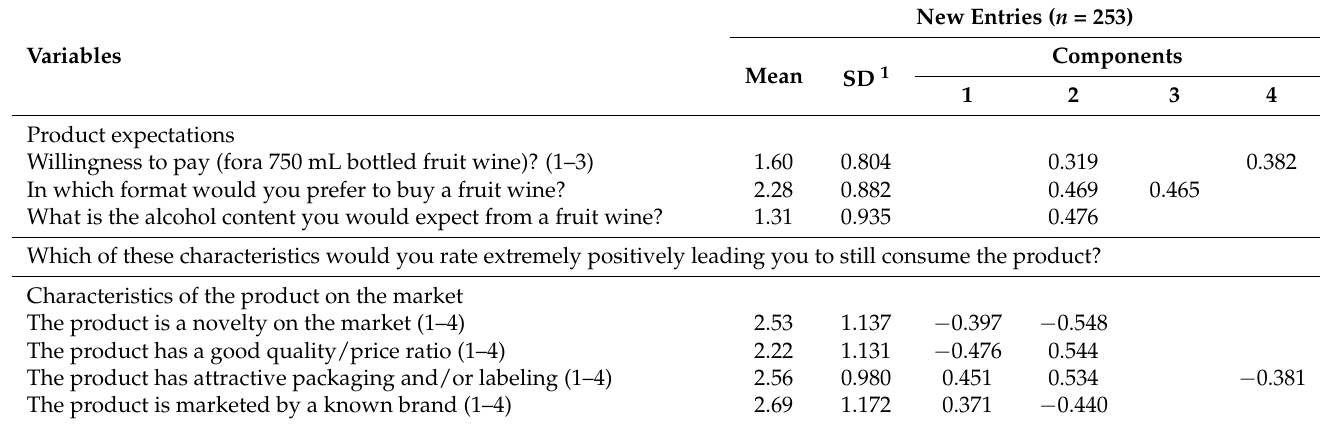
Table 6. Fruit wine expectations and perception profiles by new